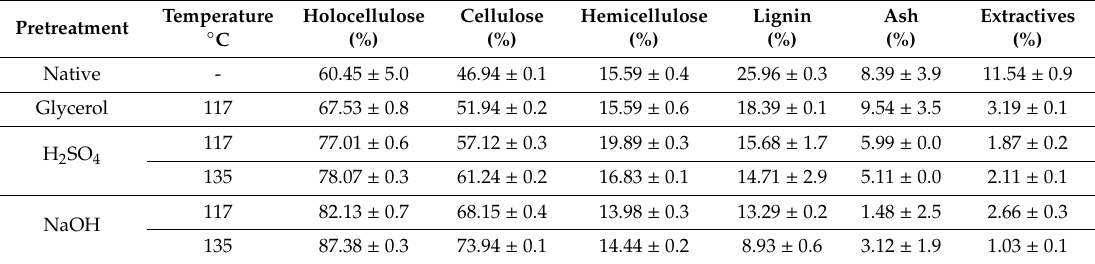
Table 1. Chemical composition of the bamboo samples with / without